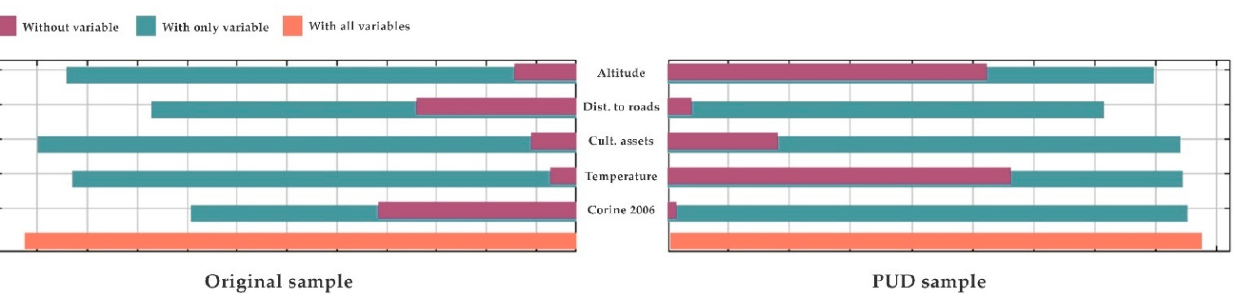
Figure 6. MaxEnt models for each sample.